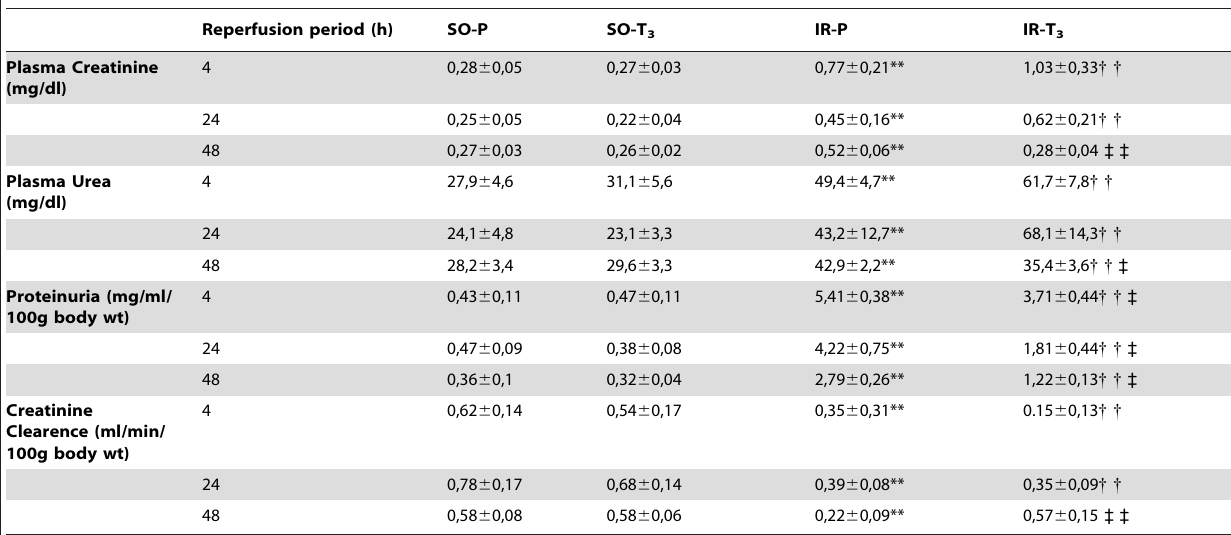
Table 1. Variables of renal